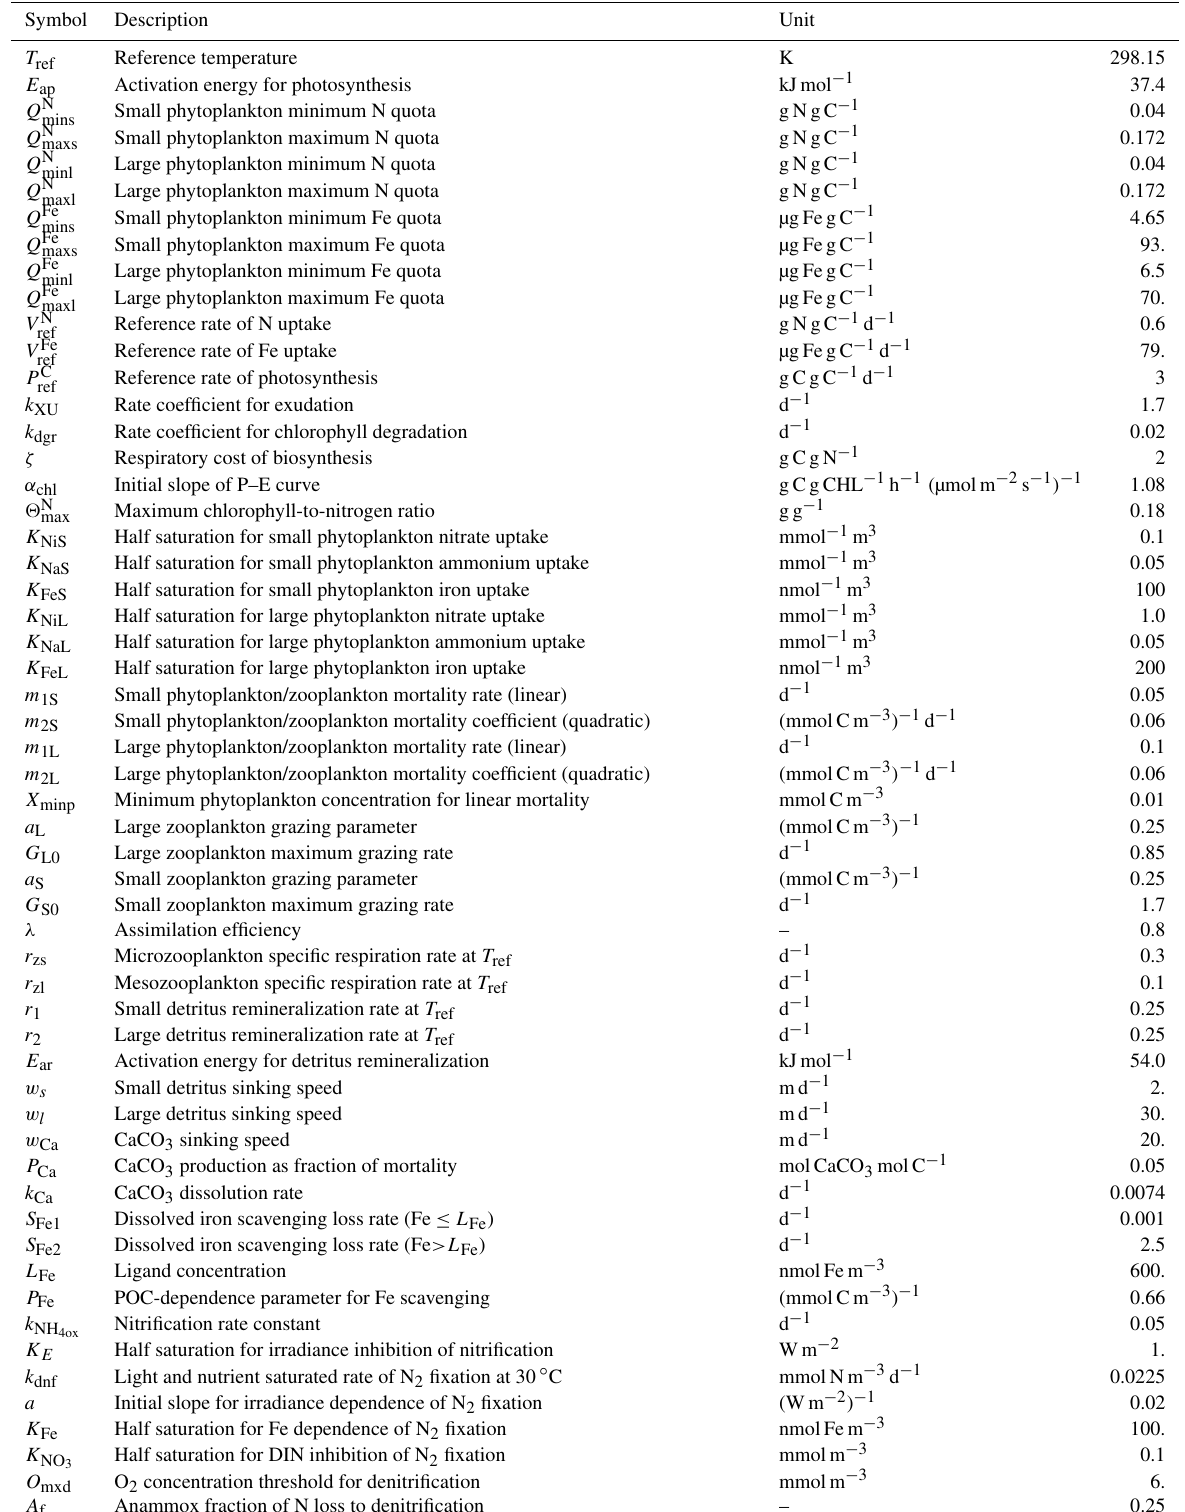
Table 1. Ecosystem model